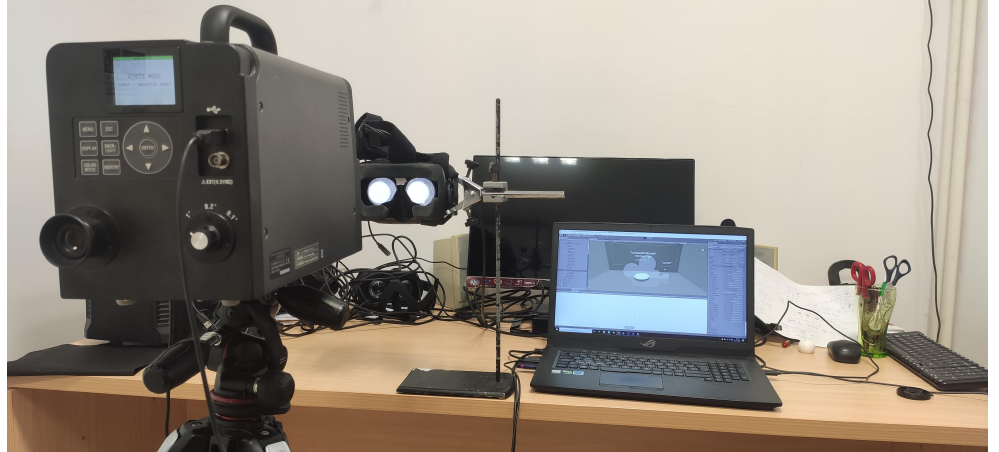
Figure 2. Experimental setup used for the chromatic characterization of the HTC Vive Device.